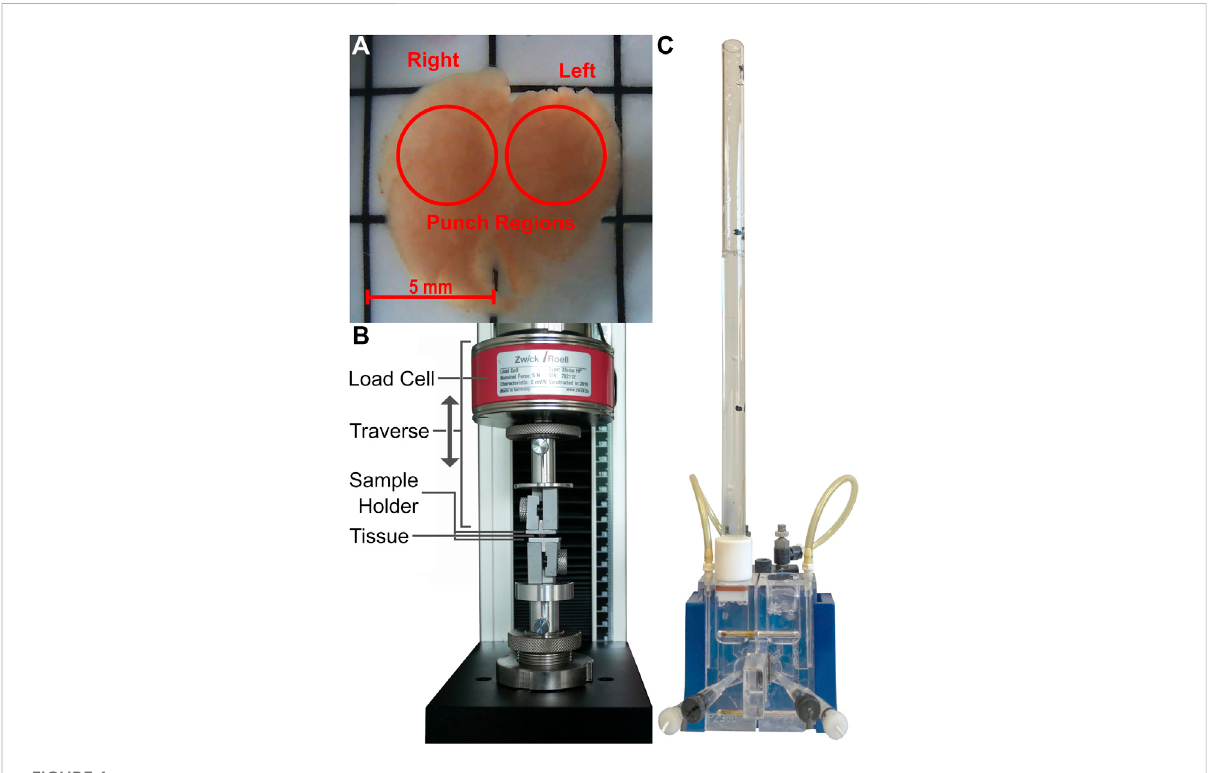
FIGURE 1 Images of the fetal rat lung after harvest (A) , the mechanical testing machine including load cell, as well as the self-designed sample holders (B) and the Ussing chamber with the applied fl uid column (C)